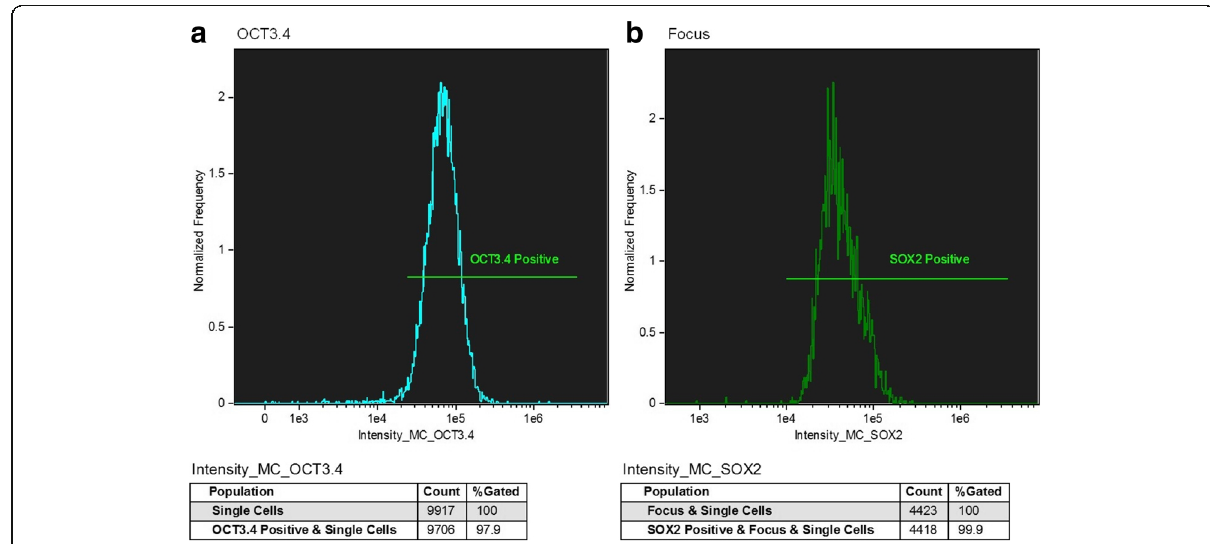
Fig. 4 Expression of cell markers OCT3.4 ( a ) and SOX2 ( b ) in mesenchymal stem cells of osteocytes using immunoglobulin and specific antibody. The number of cells analyzed was 1,000,000 for each of the labeled cell types, Purchased from AMNIS employing DiVa software 4.0 and analyzed with Flowjo / Mac version